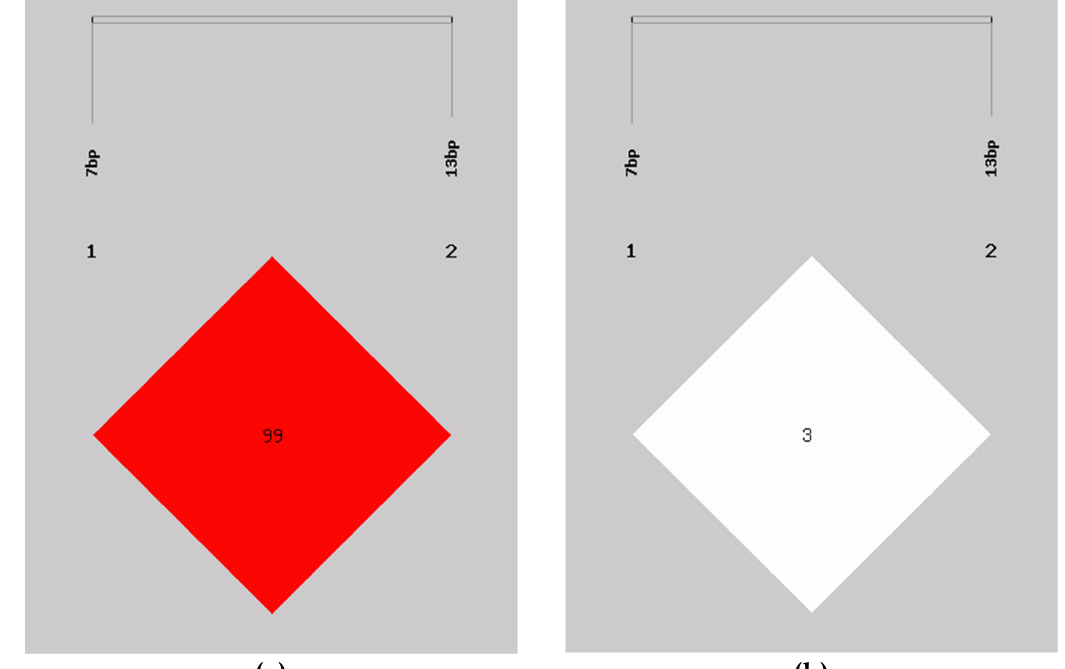
Figure 2. Linkage disequilibrium plot of the AKAP12 gene two indel loci. ( a ) D’ = 0.997; ( b ) r 2 = 0.031. Notes: “1, 2” represent the two mutation sites P1–7 bp and P2–13 bp of the AKAP12